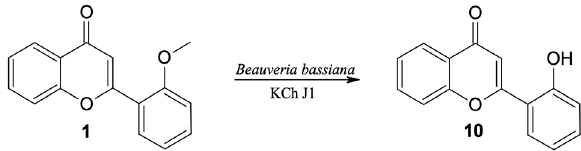
Figure 2. Biotransformation of 2’-methoxyflavone ( 1 ) by B. bassiana KCh J1.